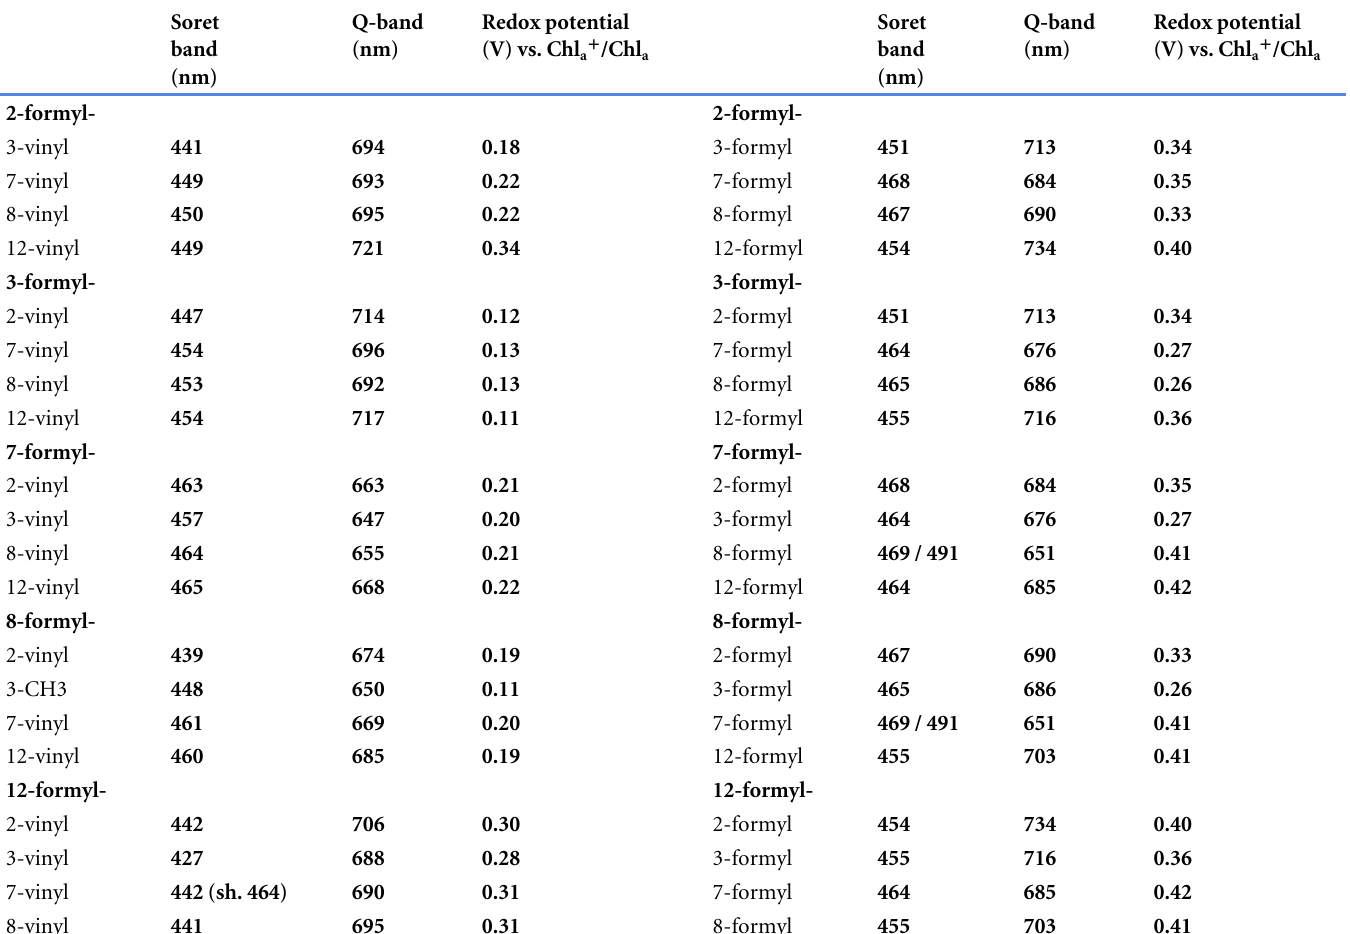
Table 4 Predicted wavelengths of the maxima of Soret and Q-bands of double-substituted chlorophylls bearing at least one additional formyl group. Band positions were computed by taking the positions of the maxima of the TDDFT-computed spectra (B3LYP/6-311G(d,p) and transform- ing them according to the linear relationships between experimental and computational maximum absorption energies described in the first para- graph of the Results section.